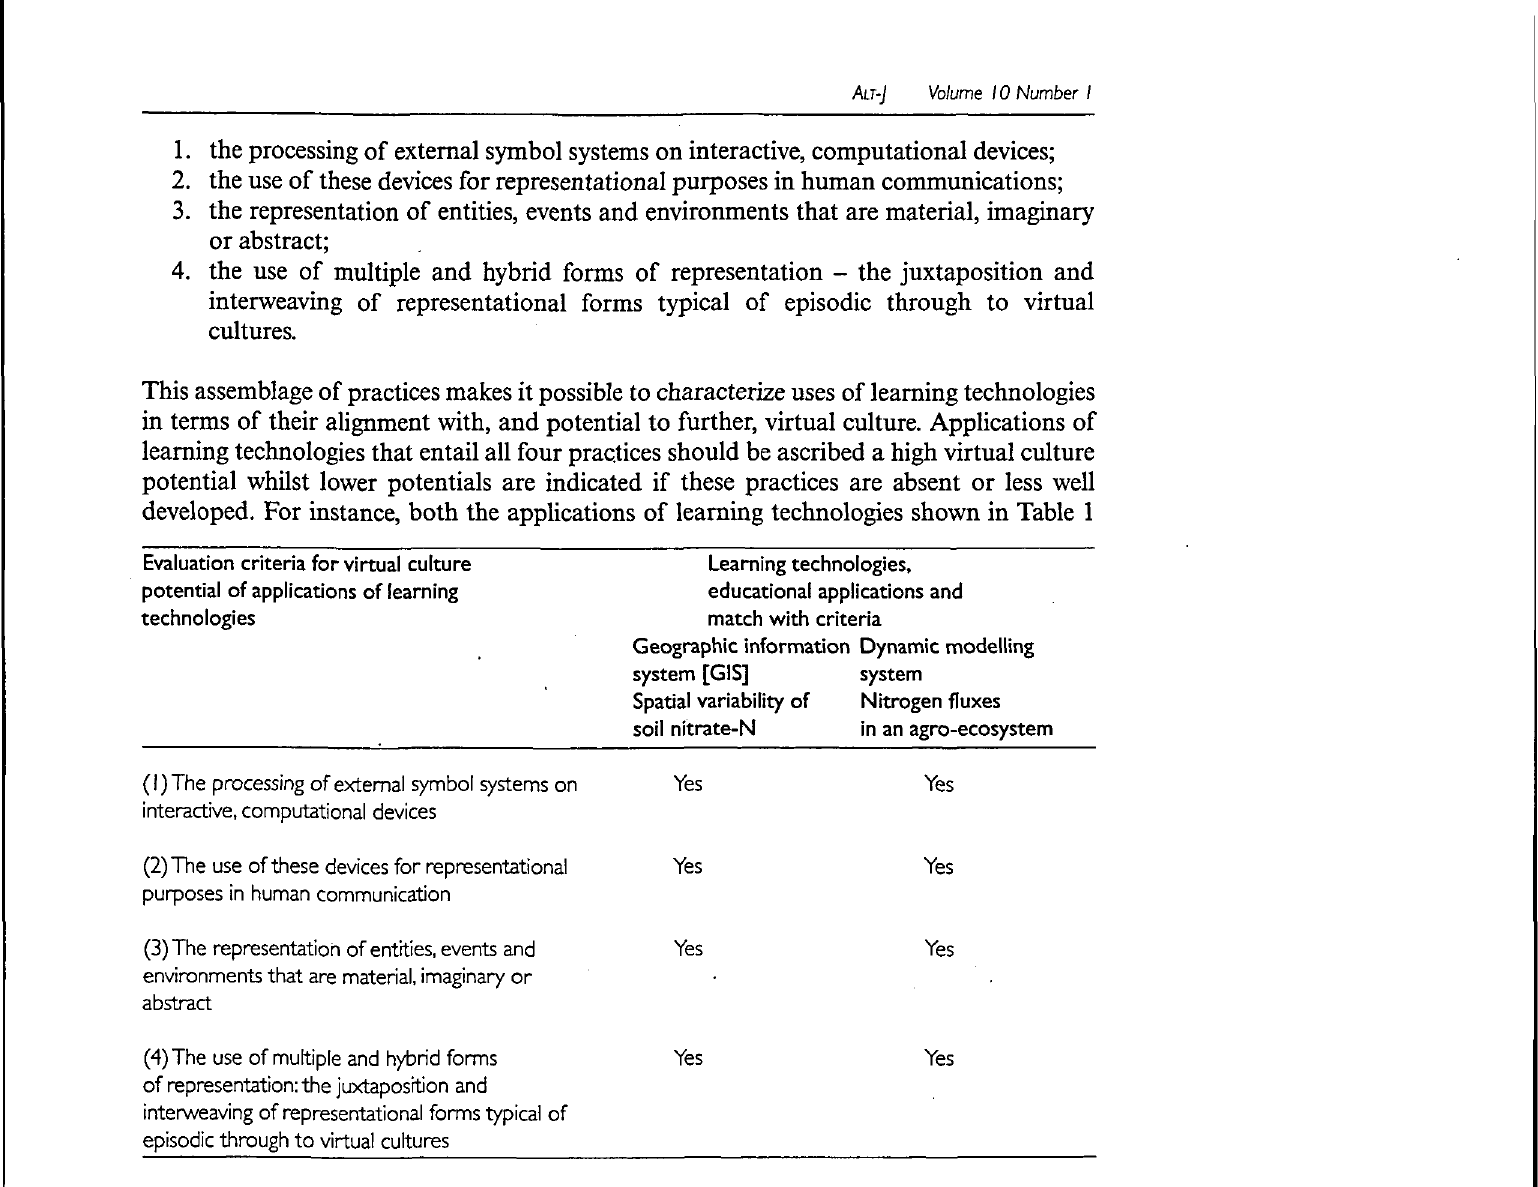
Table /: Evaluation of the virtual culture potential of two applications of learning technologies